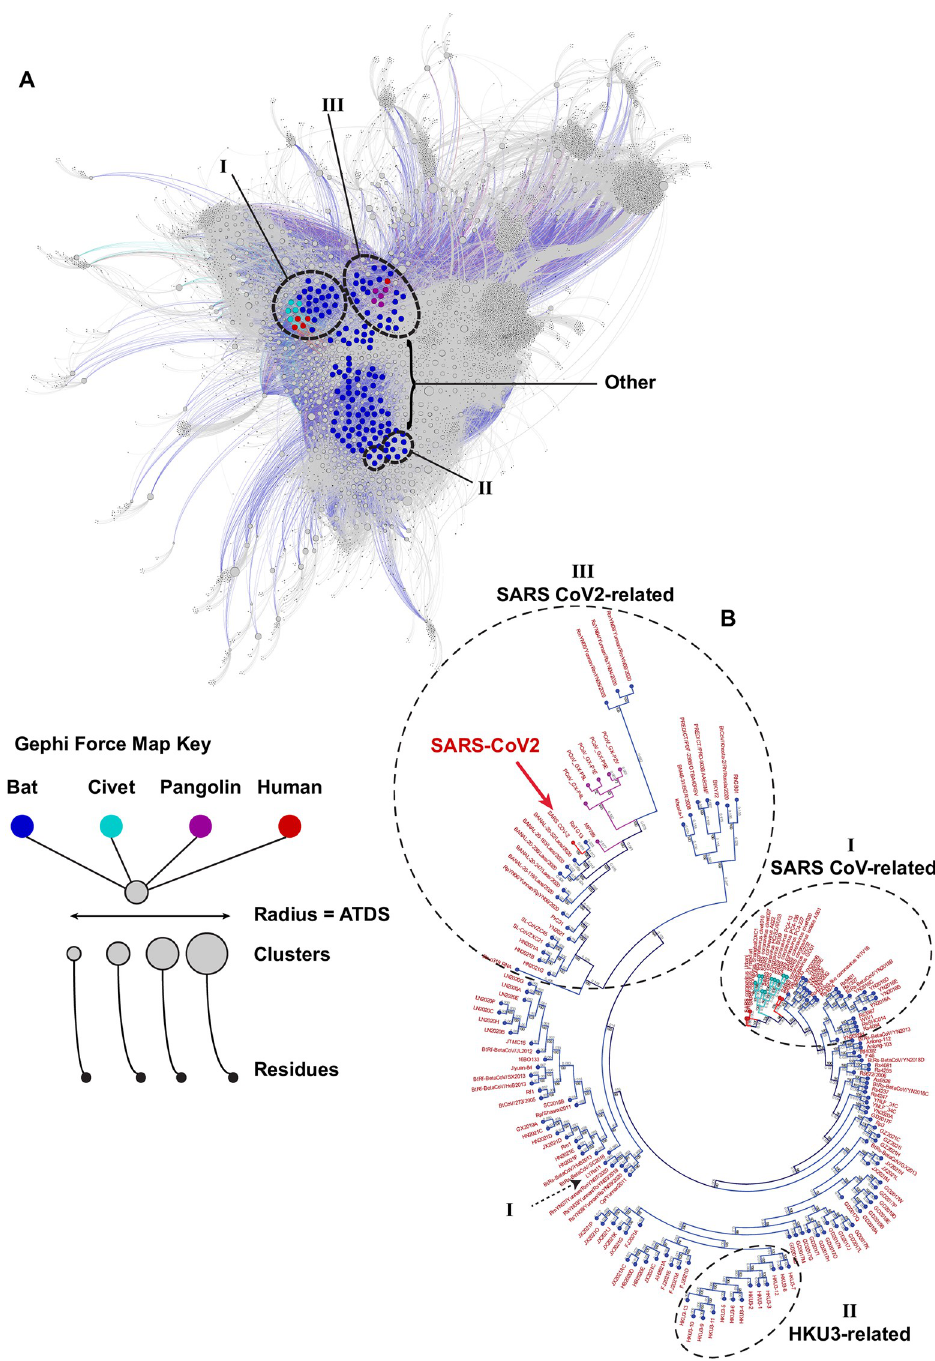
Fig 1. Force mapping graph cluster based on amino acid residue covariance and nucleotide alignment-based ML tree phylogeny both reveal similar relationships. (A) Gephi force mapping graph (Multiforce ForceAtlas 2) shows 149 CoVs based on all predicted clusters of covariant residues. The respective host for each CoV is indicated by color and the average taxonomic distribution score (ATDS) for each cluster is indicated by cluster circle size. CoVs most closely related to SARS-CoV, SARS-CoV-2, and HKU3 based on phylogeny are circled and labeled. (B) Overview of ML tree of 169 CoVs that spans nucleotides of genes ORF1a/b through N (Nucleocapsid). CoVs are colored by the host. SARS-CoV, SARS-CoV-2, and HKU3-related CoVs are circled to match groups in Fig 1A.